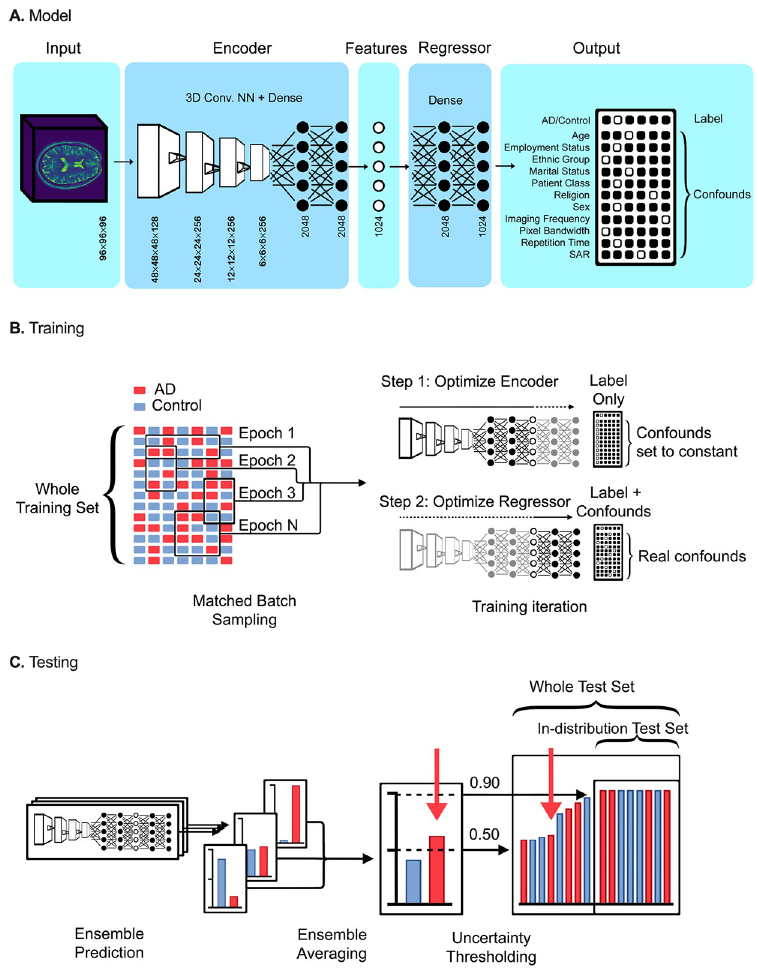
Fig 1. Multi-Confound Regression Adversarial Network (MUCRAN). A. MUCRAN is a convolutional neural network (CNN) that takes a 96 × 96 × 96 MRI as input, encodes it to an array of 1024 intermediary features via a CNN and a dense neural network, and regresses these features to an output array. The output array consists of one-hot binary vectors that encode both the primary label (AD/Control) and included confounding factors (sex, age, and so on). B. For training the regressed model, large batches are sampled from an imbalanced dataset such that AD and control are present in equal proportions. For each training iteration, the model is trained in a two-step adversarial process: with the regressor frozen, the encoder is fit to an output array with the label set to its real value, but each confound row set to a constant value ([1, 0, 0 ... 0]); the regressor is then fit to the array with both the label and its true confound values. C. For testing, labels are predicted through multiple independent models, and their votes are averaged into an ensemble vote. An uncertainty thresholding is then applied to isolate an in-distribution test set. as each confound included in the training (Fig 1A). In its training, MUCRAN is incentivized to classify an output label (AD or non-AD) without the use of confounding factors (see Meth- ods for a detailed description). MUCRAN consists of an encoder and regressor, similar, respectively, to a generator and discriminator in conventional generative adversarial neural networks (GANs) [21]. The encoder translates the input to an intermediary feature representa- tion, and the regressor translates these features to predictions of the disease label and con- founding factors (e.g., age, sex, image modality), represented by a 2-D array of one-hot vectors. In the training scheme, back-propagation is applied to the regressor and encoder alter- nately using different output arrays (Fig 1B); the regressor is trained using true output